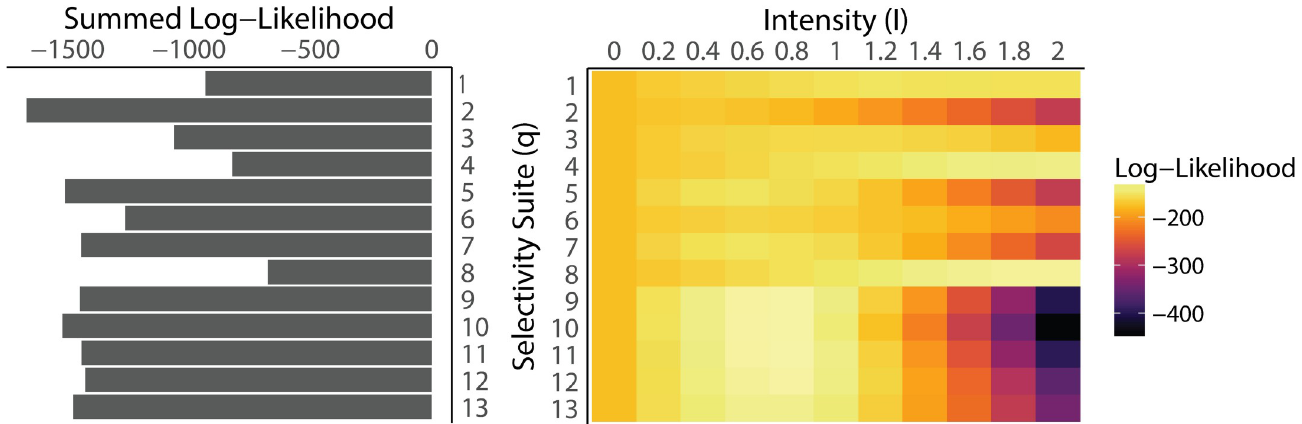
Fig 2. (Left Panel) Total likelihood for each selectivity suite summed over all mortality intensities. (Right Panel) Heat map of the log-likelihoods of all mortality scenarios by selectivity suite ( q a ) and overall intensity ( I